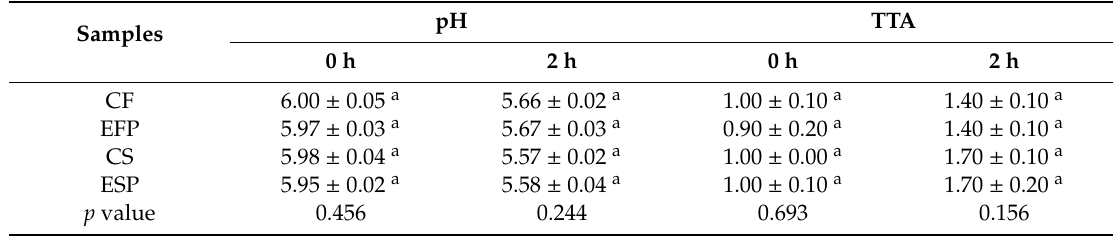
Table 1. Kinetics of acidification during